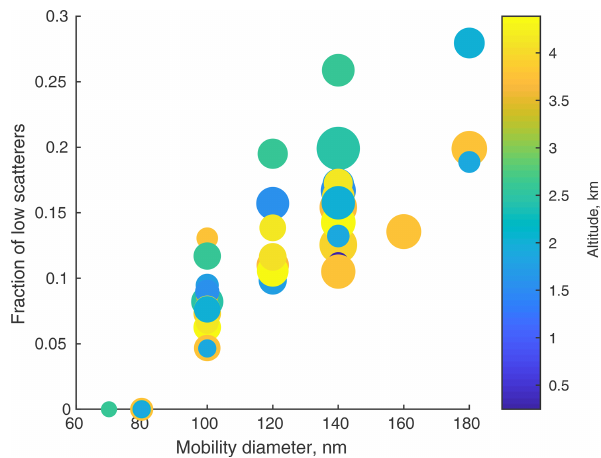
Figure 14. The fraction of particles that contained significant rBC in each ORACLES deployment, determined as the ratio of incandesc- ing particles in the SP2 to CN concentration while in the BB plume (altitude > 1500m and rBC concentrations > 50cm − 3 ). Sample pe- riods were 85s long, corresponding to an LDMA